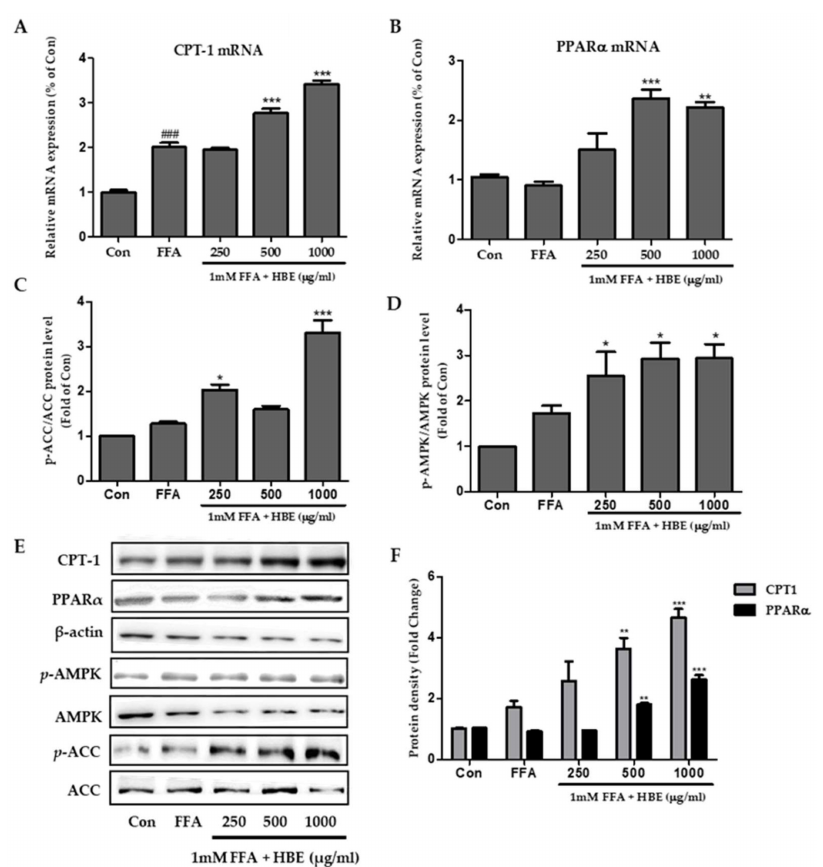
Figure 5. Effects of HBE on CPT1 and PPAR α expression and AMPK, ACC signaling in FFA-treated HepG2 cells, with and without HBE supplementation. The mRNA expression of genes associated with fatty acid oxidation factors CPT1 ( A ) and PPAR α ( B ) were quantified by real-time PCR and normalized by β -actin as an internal control. Western blot analysis of p-AMPK/AMPK ( C ) and p-ACC/ACC ( D ) in HepG2 cells. AMPK and ACC were used as a protein loading control of phosphorylated AMPK (p-AMPK) and phosphorylated ACC (p-ACC), respectively. ( E ) CPT-1, PPAR α , phosphorylated AMPK and phosphorylated ACC proteins level by immunoblot analysis. The results from three independent experiments are expressed as the mean ± SD. ( F ) Protein density of CPT-1 and PPAR α . Equal loading of protein was verified by probing β -actin. The results from three independent experiments are expressed as the mean ± SD. ### p < 0.001 vs. Con; ∗ p < 0.05, ** p < 0.01, *** p < 0.001 vs.